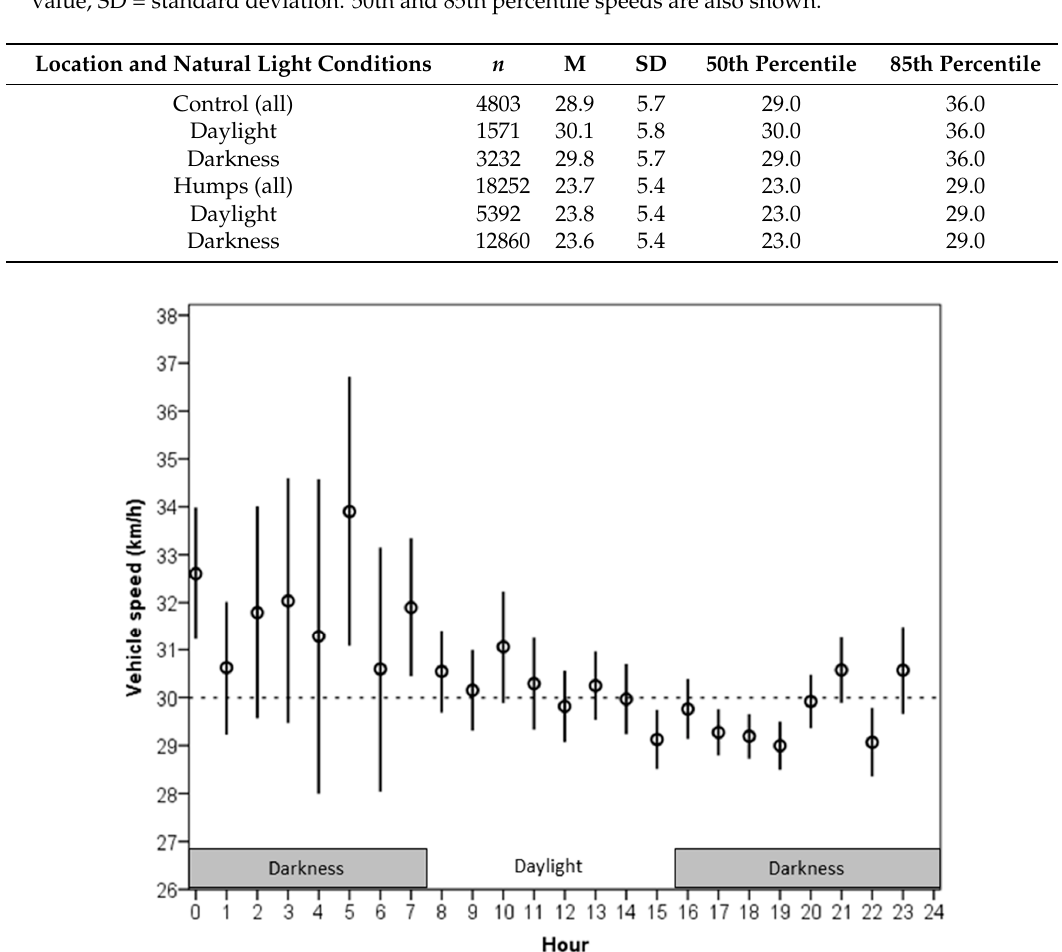
Figure 4. Mean vehicle speed at the control location during the hours of darkness and daylight over a 24-h period. Dotted line shows the posted speed limit (30 km/h). Vertical error bars: 95% confidence intervals. Measured during 4–10 November 2014 on Vreta Gårds väg in Stockholm, Sweden ( n = 4803).